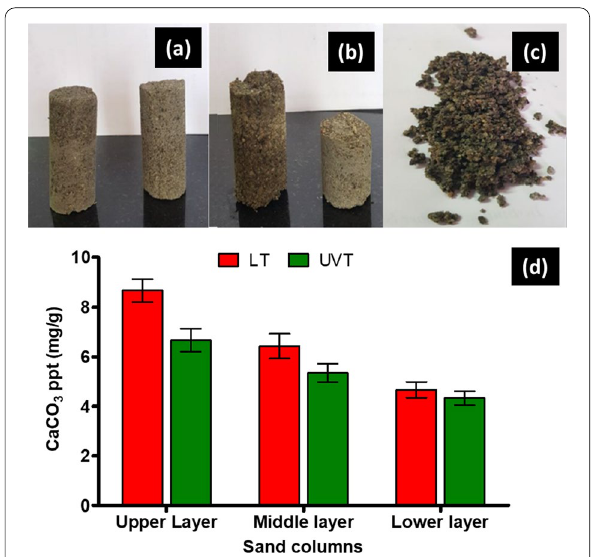
Fig. 3 Sand columns consolidated by a live (LT) S . pevalekii cells, b UV treated (UVT) S . pevalekii cells, c control, and d calcium carbonate precipitation in three different layers of sand